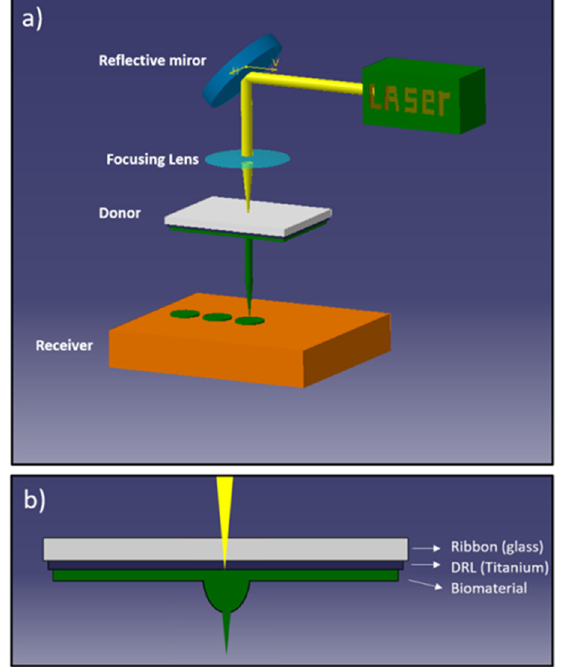
Figure 9. ( a ) Sketch of laser-assisted bioprinting technique: the laser pulse is focused by a lens on the donor substrate surface. The laser–matter interaction induces the ejection of the targeted material and its deposition on the receiver substrate in close proximity. ( b ) Zoom on the donor substrate during biomaterial ejection: the laser–matter interaction with the absorbing dynamic release layer (labelled DRL) creates an expanding and highly confined plasma, which leads to the generation of a hemispherical cavitation bubble which pushes the biomaterial layer away from the donor substrate [157].